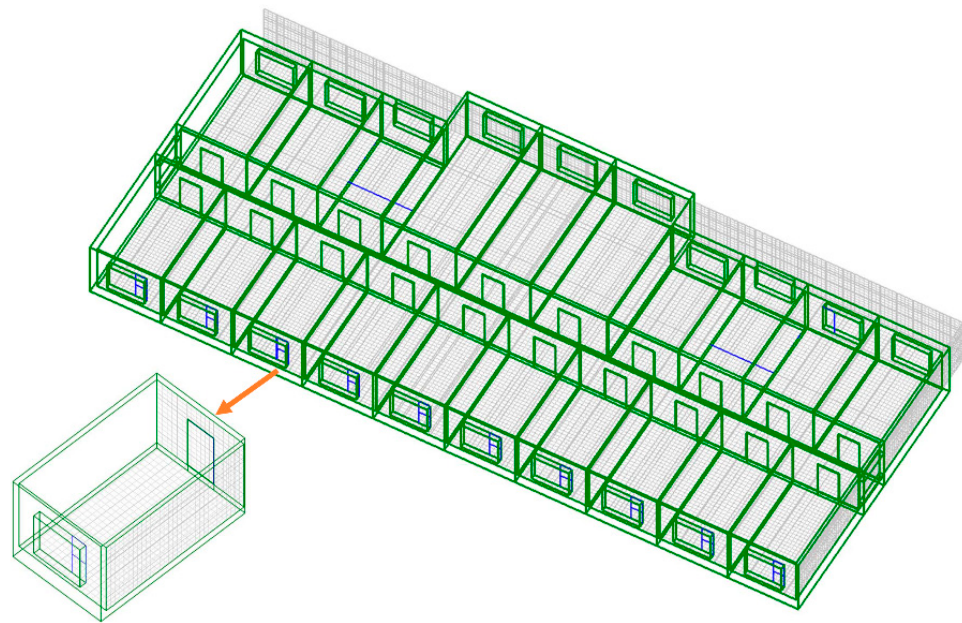
Figure 8. Computational domains: meshed geometries for room No. 403 in the south direction and all the zones on the top floor.